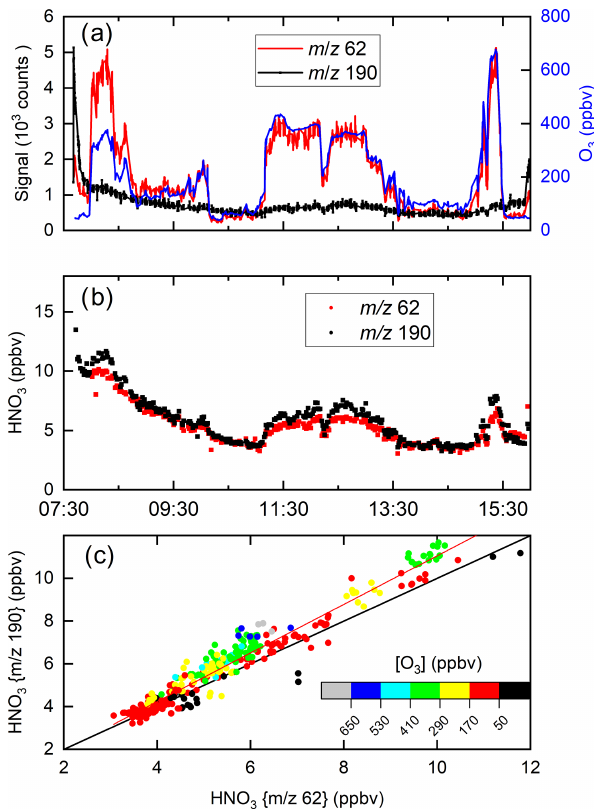
Figure 11. I-CIMS HNO 3 measurements and auxiliary data from a HALO flight during the CAFE-EU campaign. (a) Signals at m/z 62 and m/z 190 as well as O 3 mixing ratios. (b) HNO 3 mixing ratios derived from the signals at m/z 62 and m/z 190 taking the depen- dence of sensitivity on ozone and relative humidity into account. (c) Correlation of the HNO 3 mixing ratios derived from the two masses. The red line is a bivariate fit (slope 1 . 14 ± 0 . 05, intercept − 0 . 3 ± 0 . 3), and the black line is a 1 : 1 line. A large fraction of the HNO 3 measured stems from the polonium source, especially at the beginning of the flight.